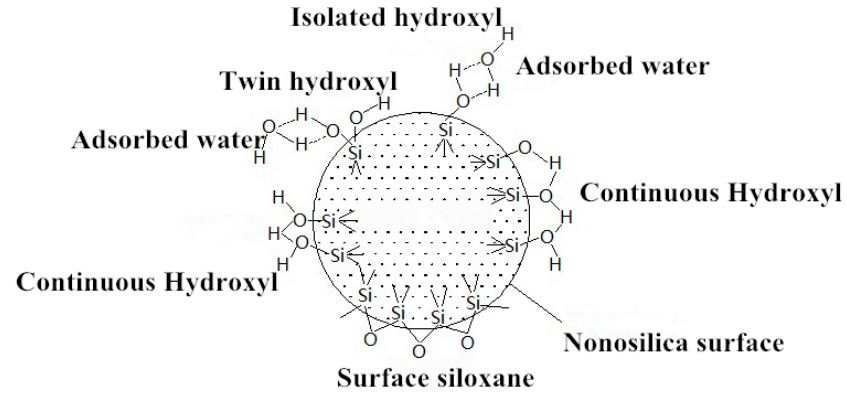
Figure 1. Surface structure of nanosilica.